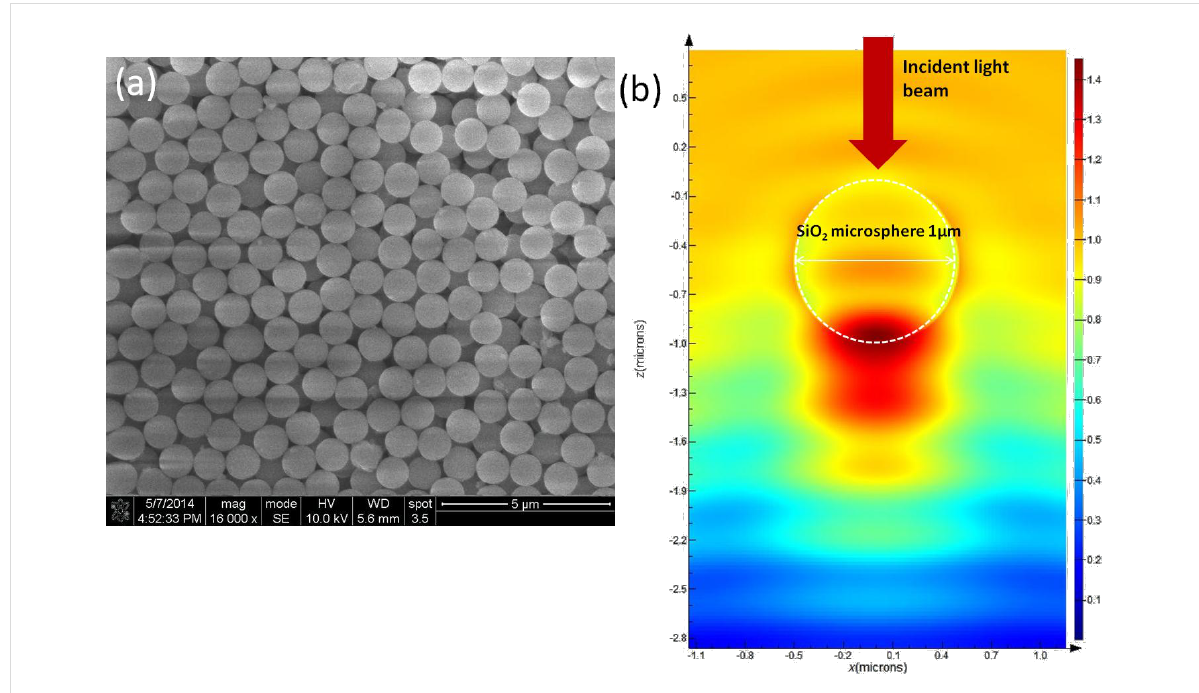
Figure 4: (a) SEM image of silica microspheres and (b) FDTD simulation result for a silica microsphere with a diameter of 1 µm under 1064 nm laser irradiation.